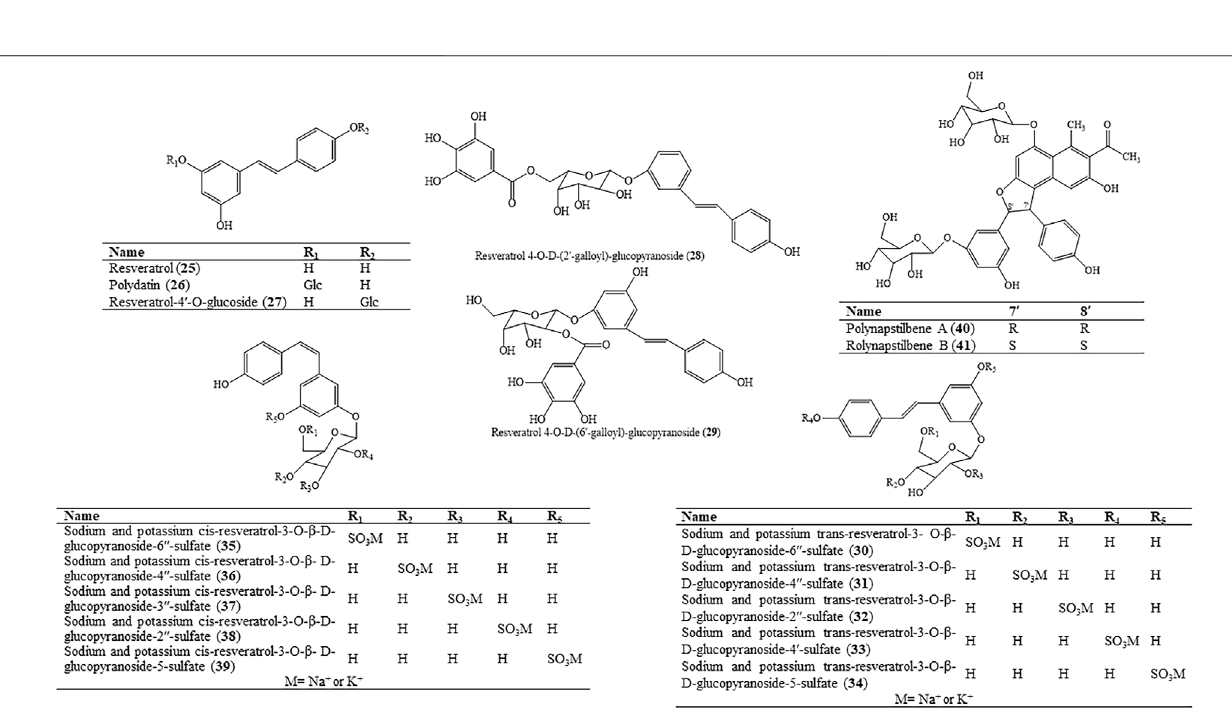
FIGURE 4 | Molecular structure of aromatic hydrocarbons in